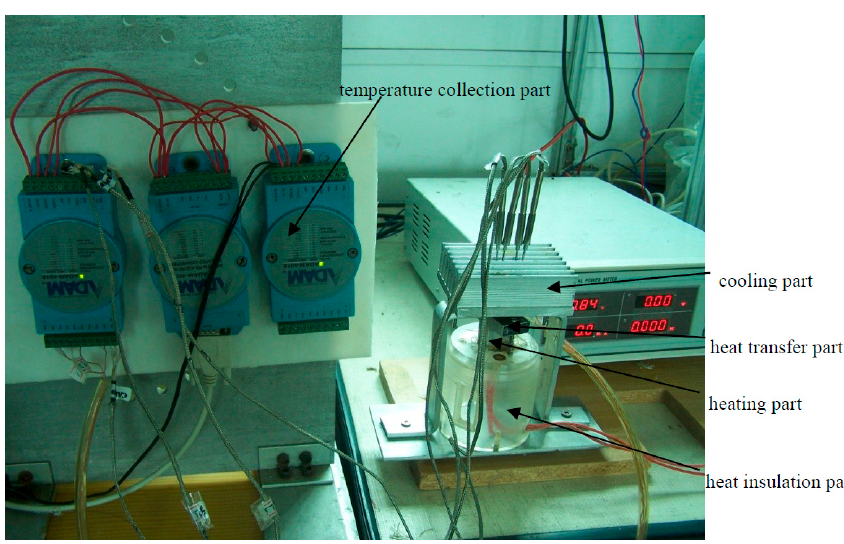
Figure 15. The heat transfer performance testing system.